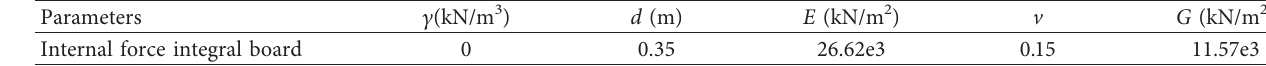
Table 6: Material parameters of the plate